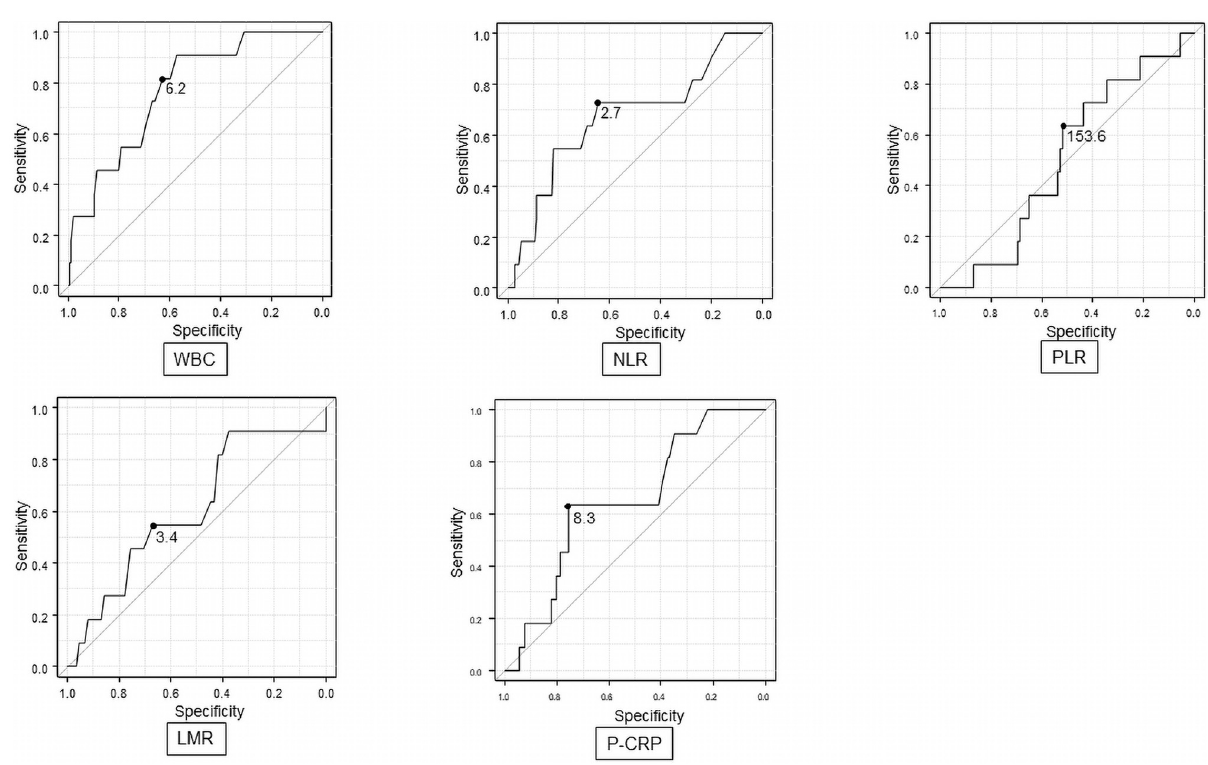
Fig 1. Receiver operating characteristic (ROC) curves and areas under the curve (AUC) of the possible predictors of anastomotic leakage. White blood cell; WBC, Neutrophil-lymphocyte ratio; NLR, Platelet-lymphocyte ratio; PLR, Lymphocyte-monocyte ratio; LMR, Platelet count × C-reactive protein level multiplier; P-CRP.